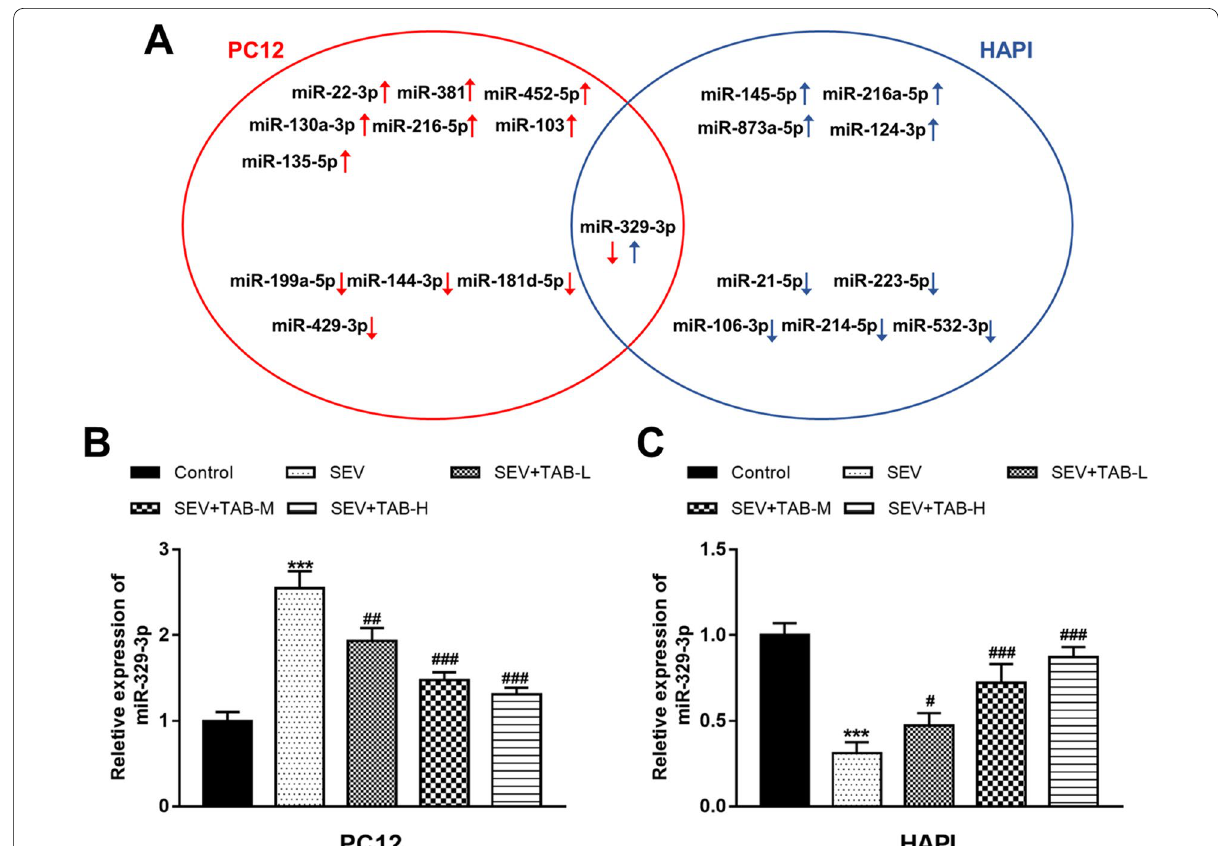
Fig. 4 miR-329-3p expression was differentially expressed in PC12 and HAPI cells after TAB treatment. A The differentially expressed miRNAs by TAB treatment in PC12 and HAPI received sevoflurane exposure. B , C miR-329-3p expression was increased in PC12 cells, but was decreased in HAPI by sevoflurane exposure, and these changes caused by sevoflurane were reversed by TAB treatment. *** P < 0.001 compared to control; # P < 0.05, ## P < 0.01, ### P < 0.001 compared to SEV